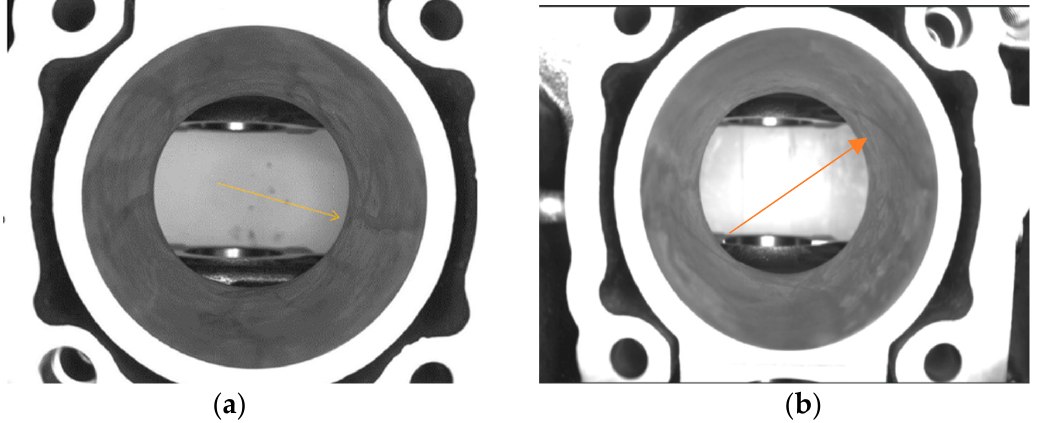
Figure 3. No defects in the cylinder chamber. In ( a , b ) can be observed a part with no defects and dried emulsion marks indicated by the arrows.